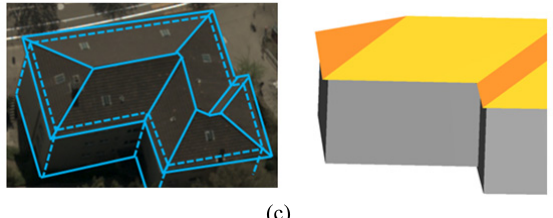
Fig.10. (a) The refined model with flat roof. (b) the refined model with complex roof structure. (c) generated roof overhangs of the building in